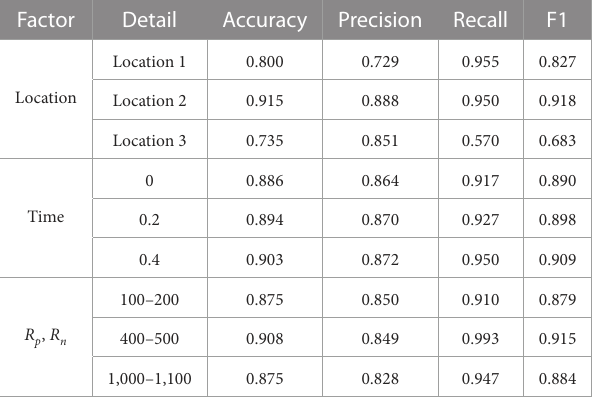
TABLE6 Simulationresultsofarcfaultsidentification. TABLE7 Differentcharacteristicsofcomparisonmethods.